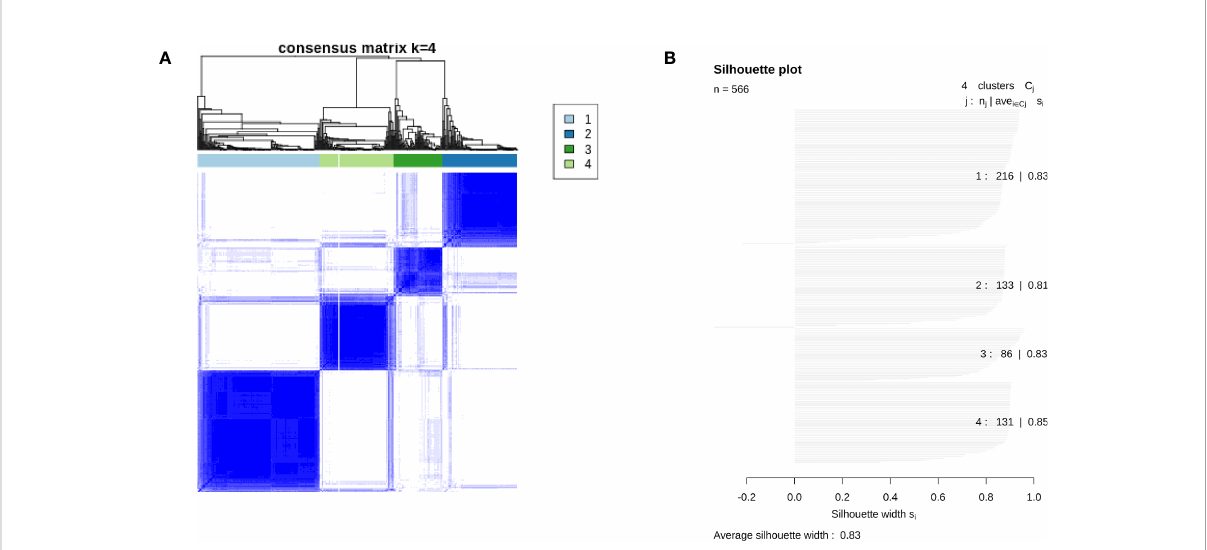
FIGURE 1 Results of consensus clustering across 566 colon tumor tissues in GSE39582. (A) Consensus matrix showing clustering consensus of each case in individuals of four immune subtypes. (B) Silhouette plot showing average silhouette score of each immune subtype and the whole population in GSE39582.